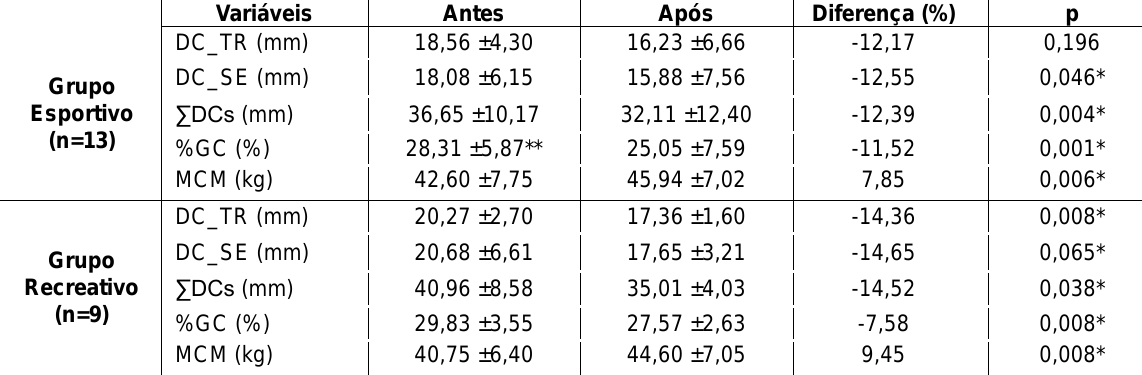
Tabela 3. Composição corporal dos adolescentes no Grupo Esportivo e no Grupo Recreativo, antes e após os programas de exercício físico.